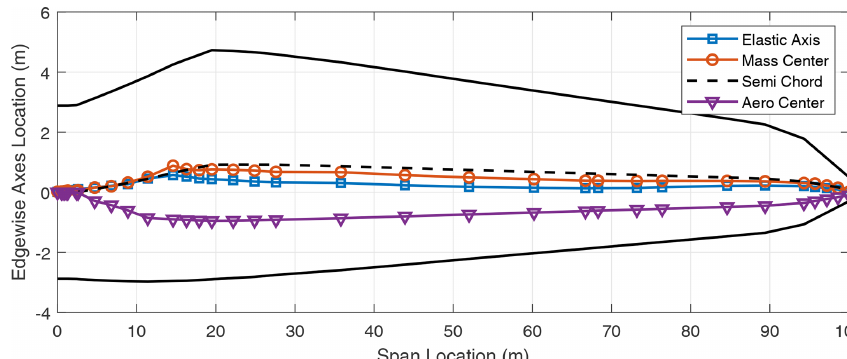
Figure A6. Planform for the SNL100-02 turbine blade.